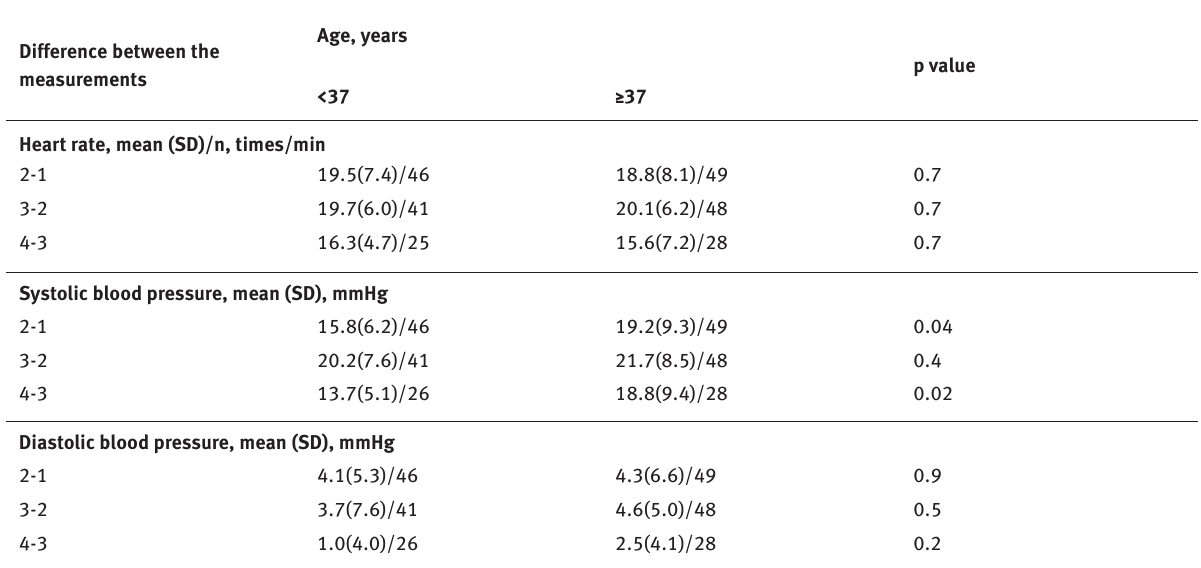
Table 5: Distribution of differences of the subjects’ heart rate, systolic and diastolic blood pressure during physical load according to age groups